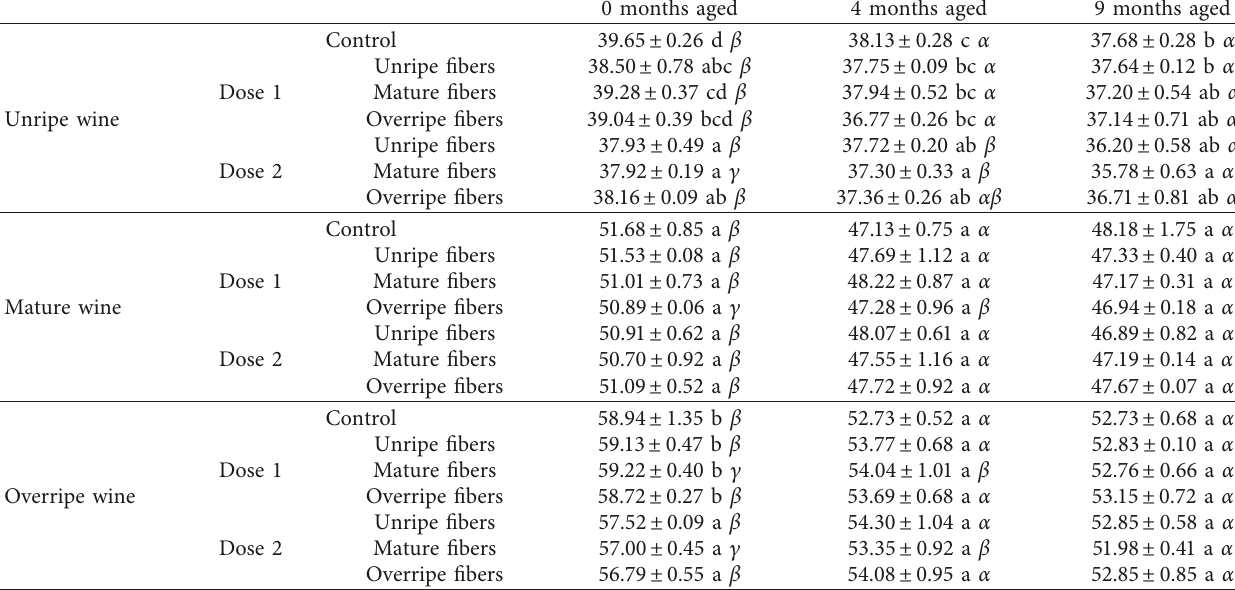
Table 2: Phenolic index (I